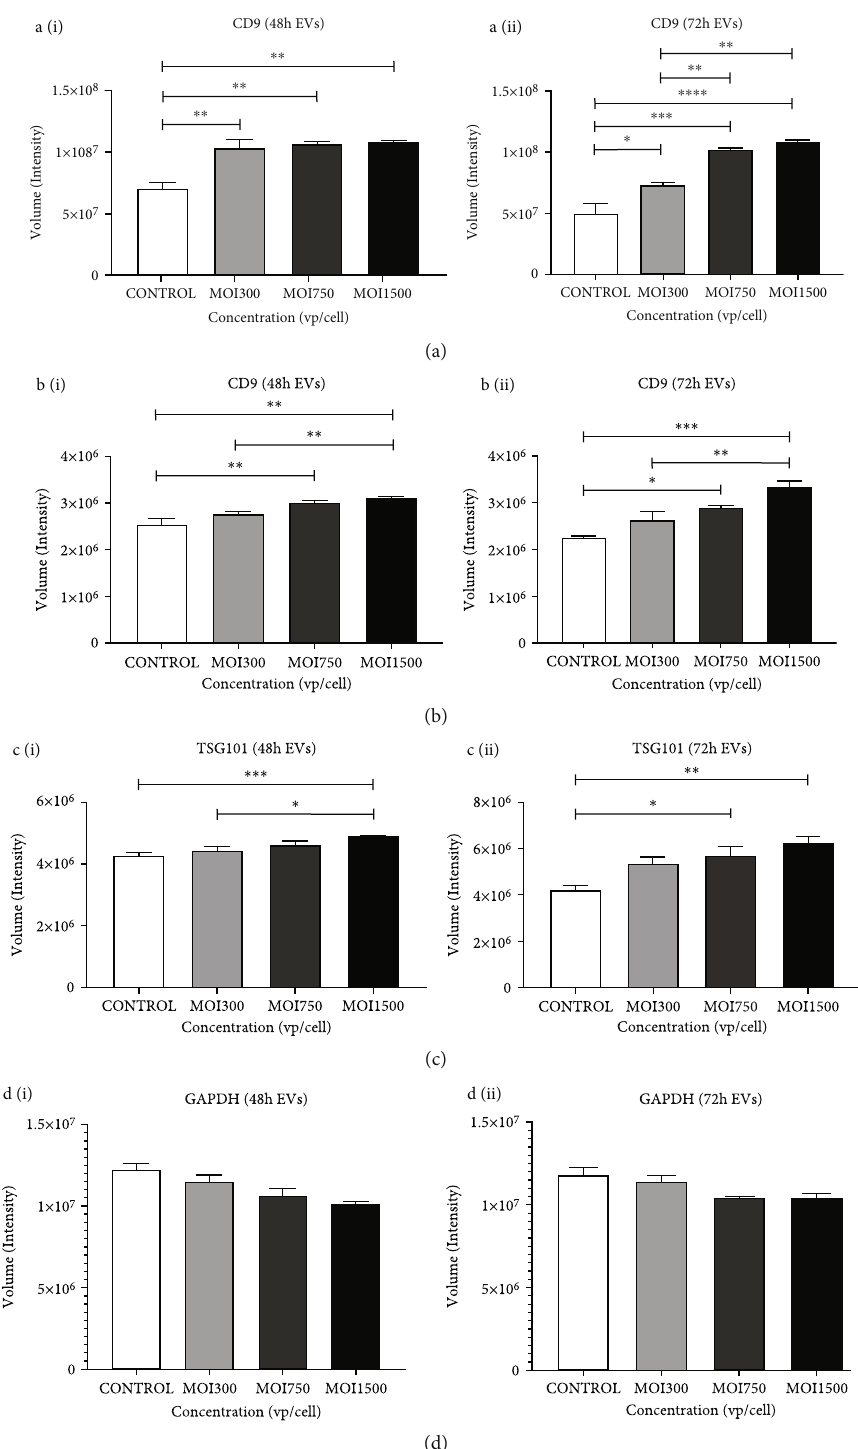
Figure 5: The e ff ect of HAdV3 infection on isolated EV classical markers. Quanti fi cation of dot blot analysis showing expression of CD9, CD63, TSG101, and GAPDH expression after 48 h and 72h infection. EVs were probed for the presence of classical markers. (a) (i) Graph showing quanti fi cation of CD9 level after 48h and (ii) 72 h of infection. (b) (i) CD63 after 48h and (ii) 72 h of infection .(c) (i) TSG101 after 48h and (ii) 72 h of infection. (d) (i) GAPDH after 48 h and (ii) 72h of infection. Dots shown in the fi gure are representative of four independent experiments. Data show mean ± SEM from three independent experiments. Data show the mean ± SEM from four independent experiments. Data shows the mean ± SEM from four independent experiments and performed using one-way analysis of variance (ANOVA) with Tukey post hoc analysis. Statistical signi fi cance is indicated by the mean ± SD as follows: ∗ p < 0 : 05 , ∗∗ p < 0 : 01 , ∗∗∗ p < 0 : 001 , and ∗∗∗∗ p < 0 : 0001